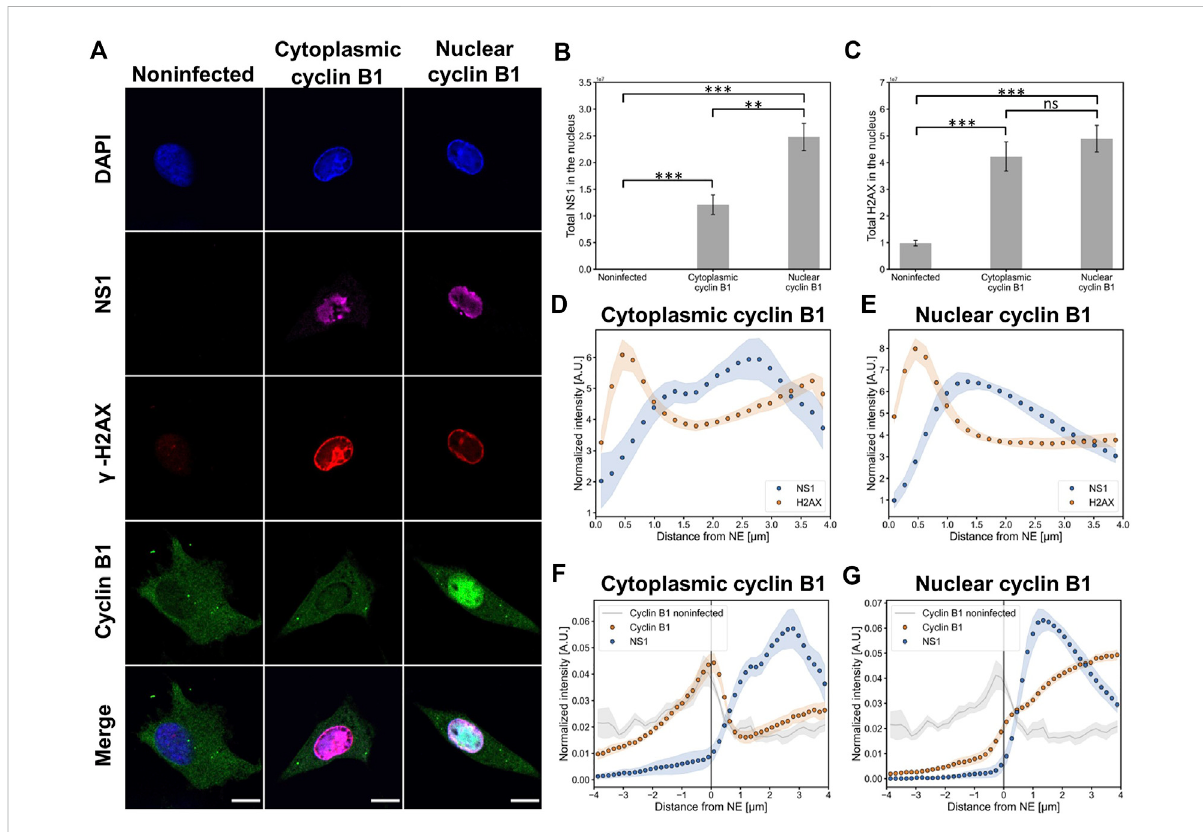
FIGURE 4 InfectioninducesDNAdamage,andtheincreaseofnuclearNS1isaccompaniedbynuclearlocalizationofcyclinB1 (A) Representativeconfocal images of nuclear and cytoplasmic localization of cyclin B1 in non-infected and infected cells at 24 hpi. NLFK cells were immunolabeled with antibodiesagainsttheviralNS1protein(magenta),DNAdamagemarker γ -H2AX(red),andcyclinB1(green).BluecorrespondstoDAPIstaining.Scale bars, 10 µm. Quantitative analyses of the amount of (B) NS1 and (C) γ -H2AX in the nuclei of non-infected ( n = 10) and infected cells with cytoplasmic ( n = 17) and nuclear (n = 9) cyclin B1. Statistical signi fi cances were determined using Games-Howell test. StatisticalSigni fi cant differencesaredenotedas***( p < 0.001)andnon-signi fi cantasns.Theerrorbarsshowthestandarderrorofthemean(SEM).Analysesoftherelative amount of nuclearNS1 (blue) and γ -H2AX(orange) as afunction ofthedistancefrom thenuclear envelope ininfectedcellswith (D) cytoplasmicand (E) nuclear cyclin B1. Intracellular distribution of NS1 (blue) and cyclin B1 (orange) in infected cells with (F) cytoplasmic and (G) nuclear cyclin B1. Cyclin distribution (grey) in non-infected cells is also shown. The 2D nuclear boundary reconstruction located at x = 0 was based on the distribution of DAPI-labeled chromatin. The shaded areas around the data points represent